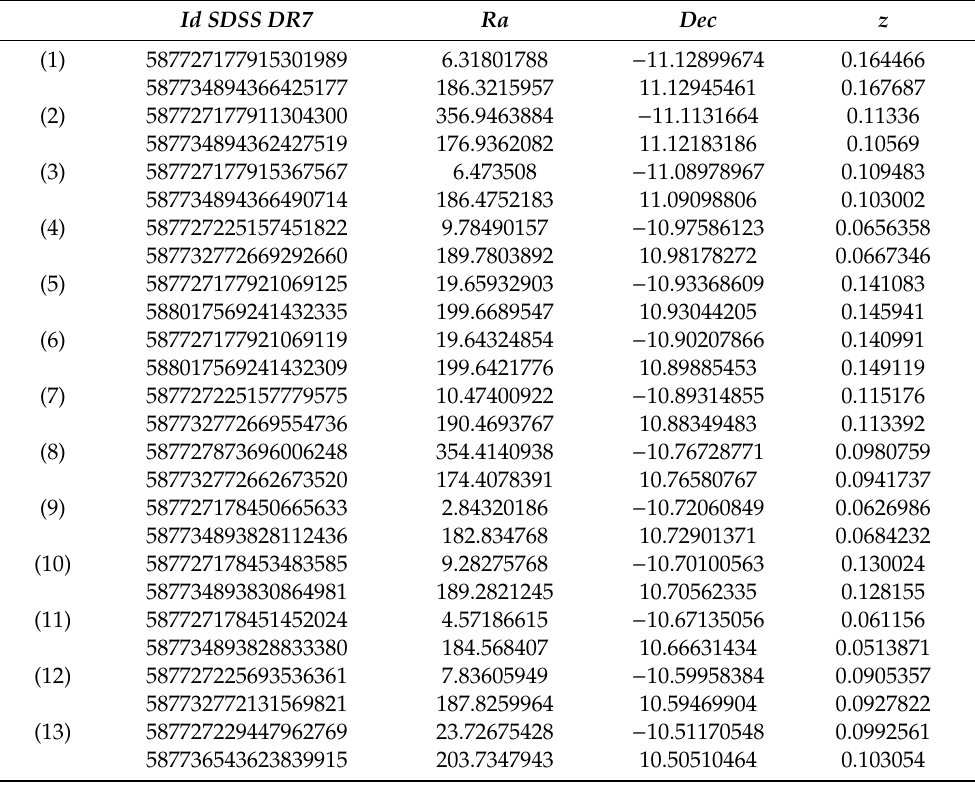
Table A1. Pairs of galaxies for the e ff ect of cosmic mirror [36]. Id SDSS DR7 is objID identification number in the Sloan Digital Sky Survey. Accuracy is of 0.01 ◦ for ra and dec and 0.01 for z . Pair is a valid candidate for the e ff ect only if both galaxies in the pair are